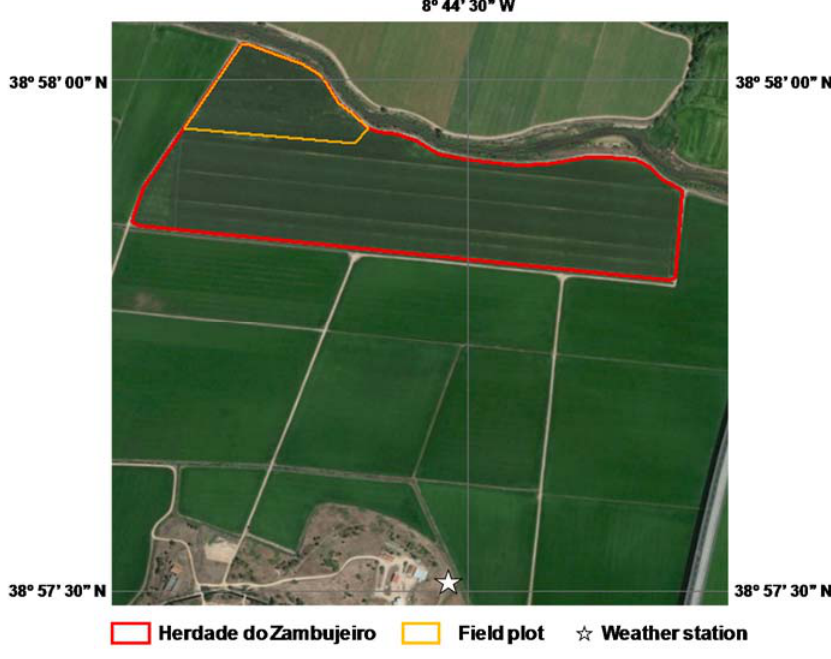
Figure 1. Location of the study site.